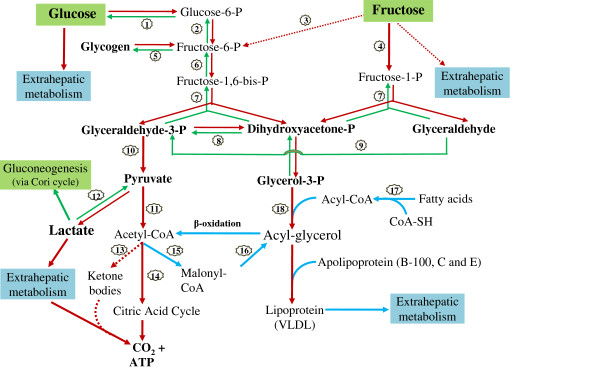
Major metabolic pathways and flux of dietary glucose and fructose. P = phosphate. For enzymes numbered in circles: 1 = hexokinase/glucokinase or Glucose-6-phosphatase, 2 = phosphoglucose isomerase, 3 = hexokinase, 4 = fructokinase, 5 = glycogen synthase or phosphorylase, 6 = phosphofructokinase, 7 = aldolase, 8 = triose phosphate isomerase, 9 = triose kinase, 10 = several enzymes including pyruvate kinase, 11 = pyruvate dehydrogenase complex,12 = lactate dehydrogenase,13 = ketothiolase and other 3 enzymes,14 = enzyme group related to citric acid cycle, 15 = acetyl CoA carboxylase,16 = multienzyme complexes, 17 = acyl CoA synthase, 18 = glycerol-phosphate acyl transferase and triacylglycerol synthase complex. The dashed-line and arrow represents minor pathways or will not occur under a healthy condition or ordinary sugar consumption. The compound names in bold would be major metabolic intermediates or end products of glucose or fructose metabolism.